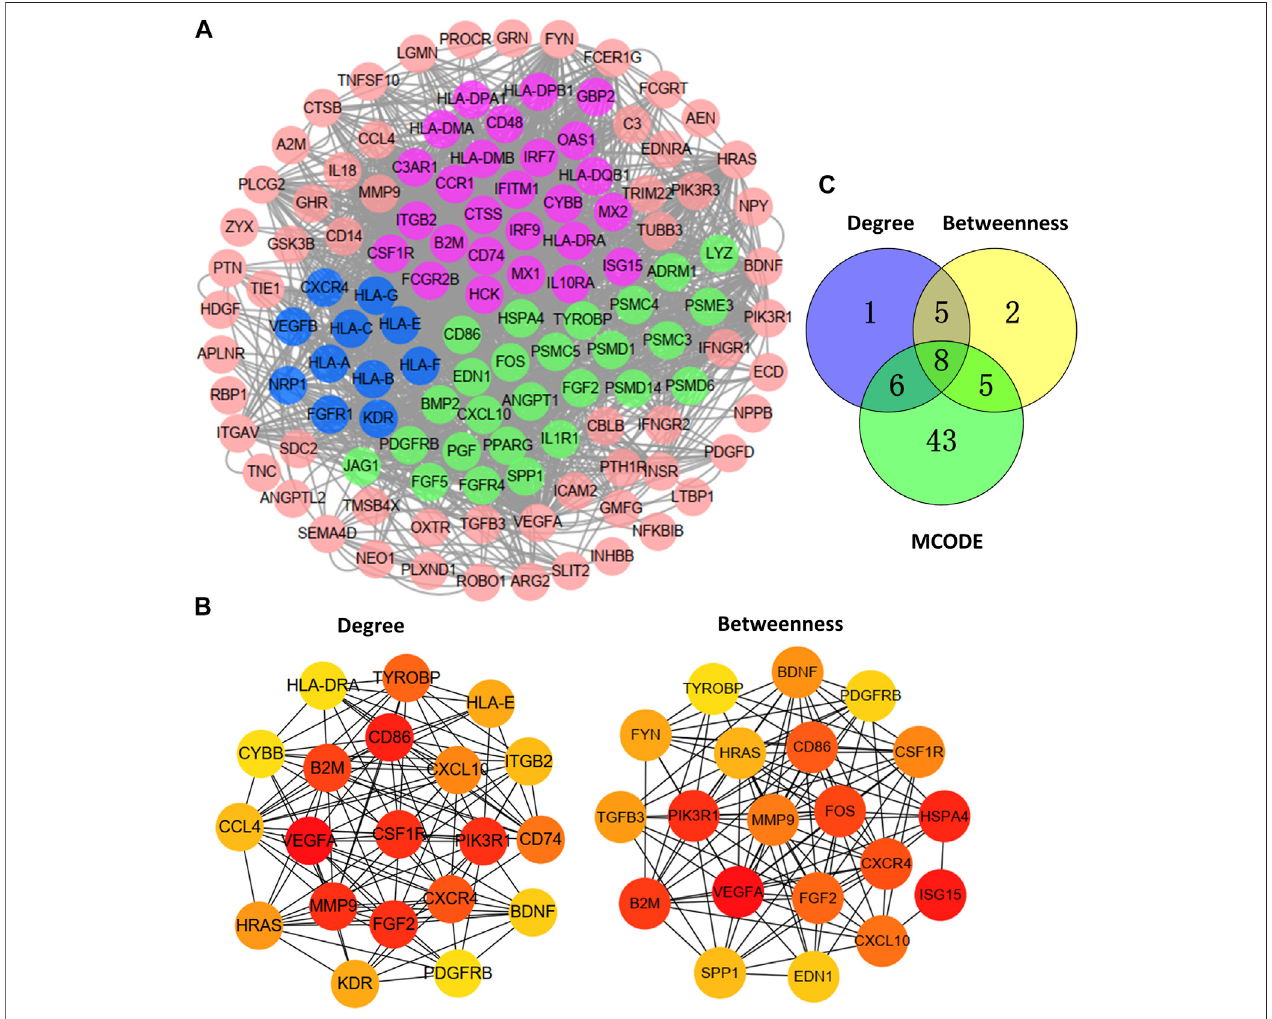
FIGURE 2 | Hub genes and biology network. (A) Protein-protein interaction (PPI) network of 129 differentially expressed IRGs and three critical modules. (B) Identifying the fi rst 20 IRGs and constructing the corresponding PPI network using the degree and betweenness topological method. (C) Venn calculation applied to identify eight hub